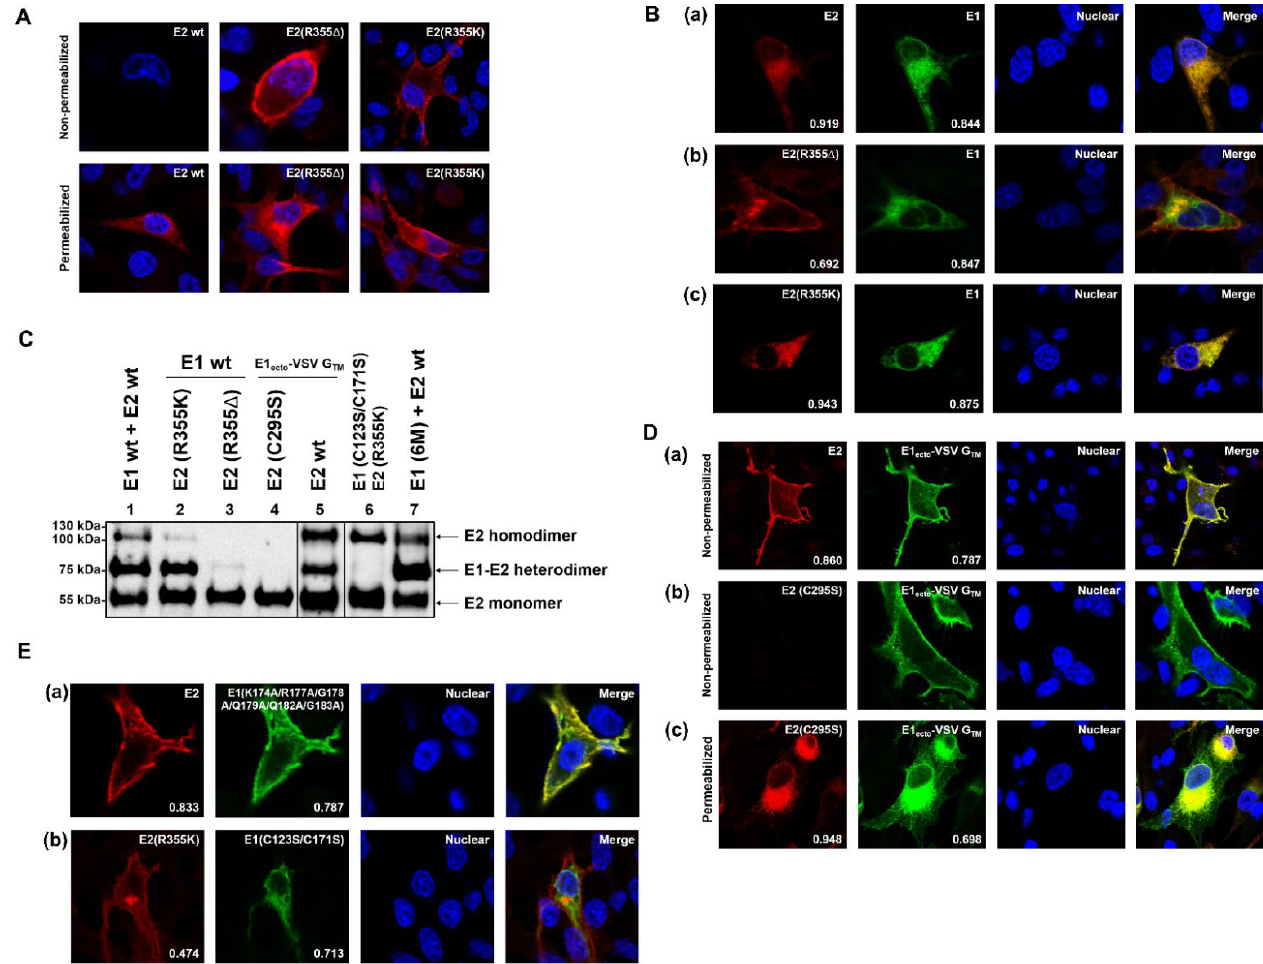
Figure 5. Presence or absence of the E1 retention signal determines the cellular localization of the E1/E2 heterodimer. ( A ) Subcellular localization analysis of E2 (or variants). BHK-21 cells were transfected with the given expression plasmids, fixed with 4% PFA on the following day and analyzed via confocal microscopy. E2 was detected with α-AU1 and α-abbit-AlexaFluor-594. ( B , D , E ) Co-localization analysis of E1 (or variants) and E2 (or variants), Mander’s coefficients for colocalization of E2 with E1, and E1 with E2 signal are displayed at the bottom of the pictures. Magnification 500 × . BHK-21 cells were transfected with the given expression plasmids, fixed with 4% PFA on the following day and analyzed via confocal microscopy. In the lower row of A and ( D ( c )) all of the cell membranes were permeabilized with 0.05% Triton-X100 whereas in the upper row of A as well as in ( D ( a , b )), the samples were not permeabilized to analyze surface localization. Cells in ( B , E ) were all permeabilized with Triton-X100. E1 was detected with α -HA (IgG3), α -mouse (IgG3), and AlexaFluor-488; E2 was detected with α-E2 1b31 mAb (IgG1) from BVDV-Mix [33] and α-mouse (IgG1)-Cy3. ( C ) Western blot analysis for E1/E2 heterodimer formation of the indicated proteins. The given E1 wt/E1 mutant expression plasmids were co-transfected with plasmid coding for E2 wt/E2 mutants into RK-13 cells, respectively, and co-expression products were analyzed via nonreducing SDS-PAGE and western blot on the following day. Western blot analysis was carried out using primary antibody: mAb α-E2 (WB214), secondary antibody: α-mouse PO to show the E1/E2 heterodimer and E2 monomer/homodimer. A file is provided in the Supplementary Materials with the original western blot results to demonstrate that the different parts were derived from equivalent gels and that one of these gels contained a mock control. As a next step, we examined these two E2 mutants for their ability to form heterodi-